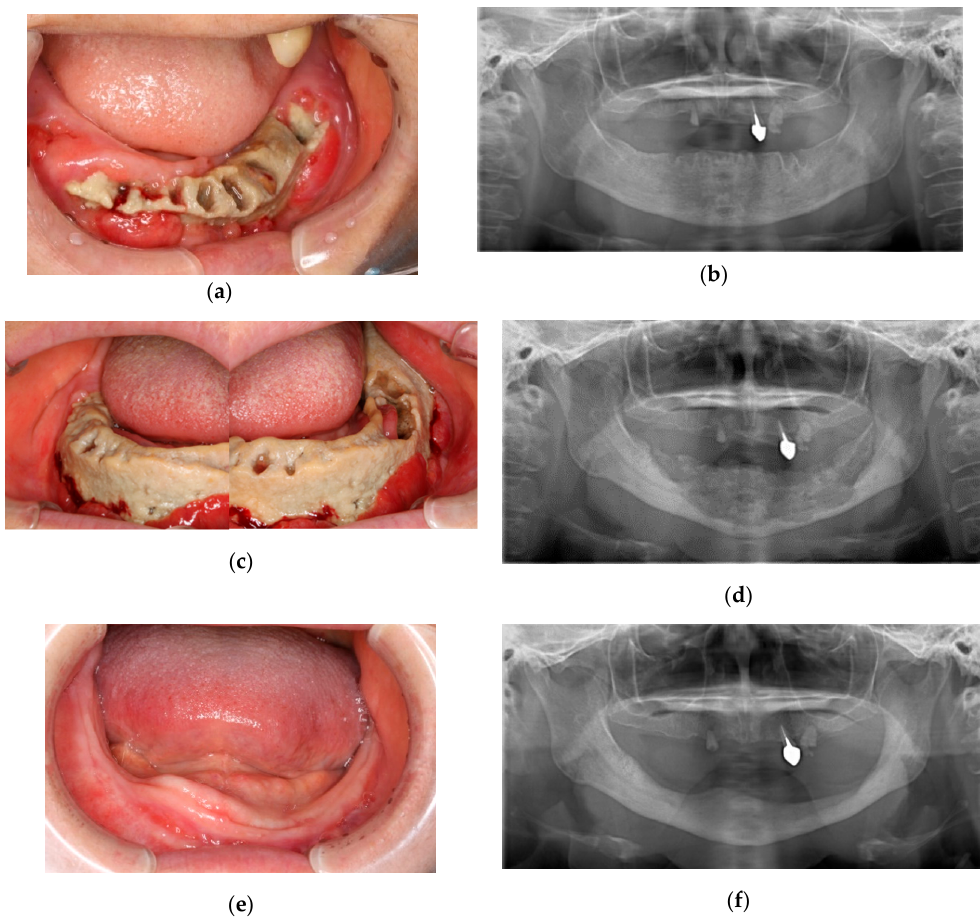
Figure 1. Representative case of a 61-year-old woman with bone metastases diagnosed as stage 3 denosumab-related osteonecrosis of the jaw (DRONJ) after surgical treatment and adjuvant hormone therapy for invasive ductal breast carcinoma. Denosumab was administered after chemotherapy and targeted therapy. After 16 months of denosumab administration, intraoral mandibular necrotic bone exposure, together with progressive spontaneous tooth loss was first observed during oral follow-up (( a ) intraoral photo; ( b ) panoramic radiograph). Over the next 8 weeks, disease progression